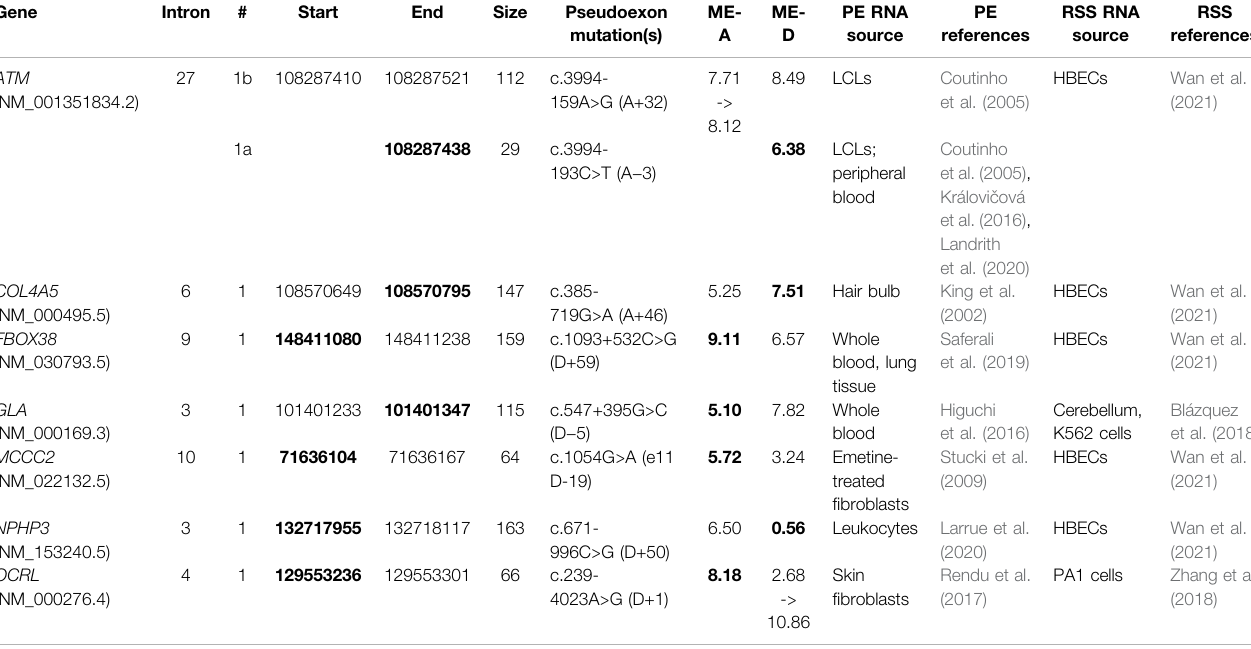
TABLE 2 | Pseudoexons associated with seven con fi rmed intronic recursive splice